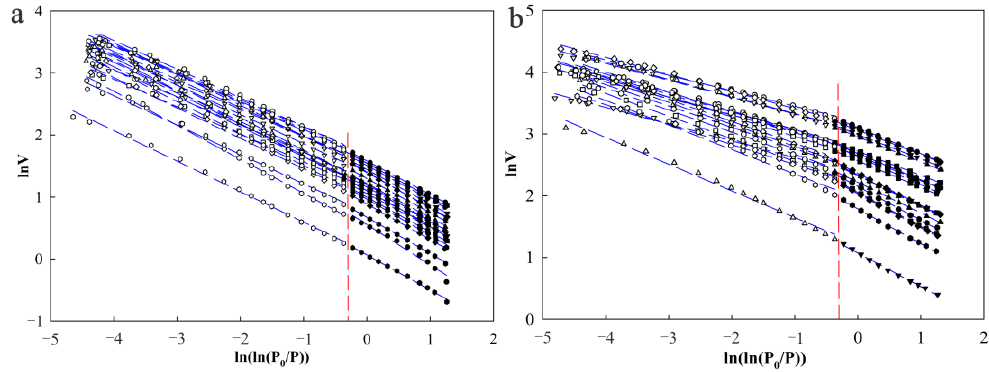
Figure 8. The plots of lnV versus ln(ln(P 0 /P)) of studied lacustrine samples in ( a ) K 2 qn 1 and ( b ) K 2 qn 2,3